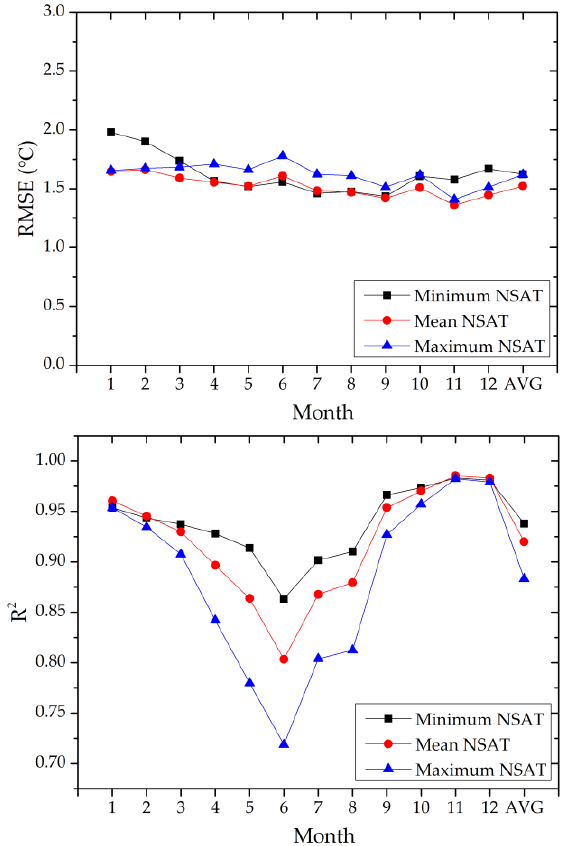
Figure 3 RMSE and R 2 of the predicted monthly minimum, mean, and maximum near surface air temperature using the geographically weighted regression model in China in 12 months of 2010. Figure 4 represents the RMSE and R 2 of the predicted monthly mean NSAT using GWR model for varied terrain types in China in 12 months of 2010. As shown in Figure 4, with month change, the RMSEs using the GWR model for plateaus, hills, and plains are stable, while the RMSEs for basins are variable. The mean RMSEs of 12 months using the GWR model are 2.09 °C for plateaus, 1.41 °C for basins, 0.48 °C for plains, and 1.13 °C for hills, respectively. The mean RMSE for plateaus and basins is higher than that of hills and plains. One possible reason for this is that the weather station density of hills and plains is greater than that of plateaus and basins. The R 2 values of GWR model decrease first and then increase as the month progresses for all terrain types. The mean R 2 values of 12 months using the GWR model are 0.85 for plateaus, 0.87 for basins, 0.94 for plains, and 0.94 for hills,